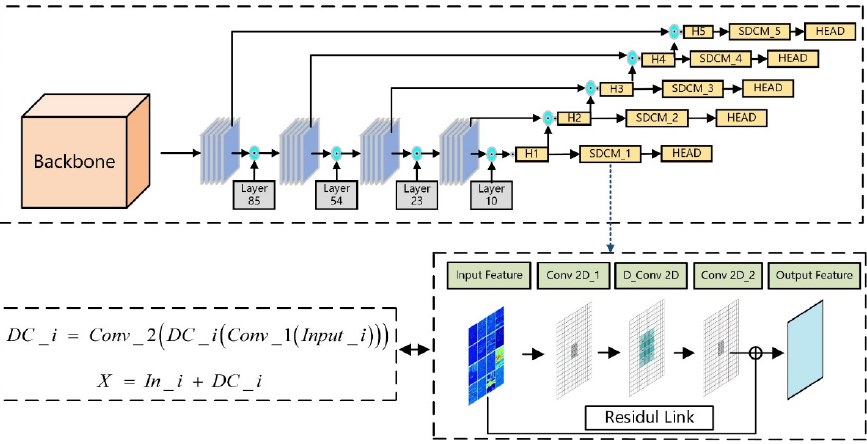
Figure 2. Schematic diagram of the overall structure of YOLOv4-SDCM. Table 1. The dilation rates of different scale features.